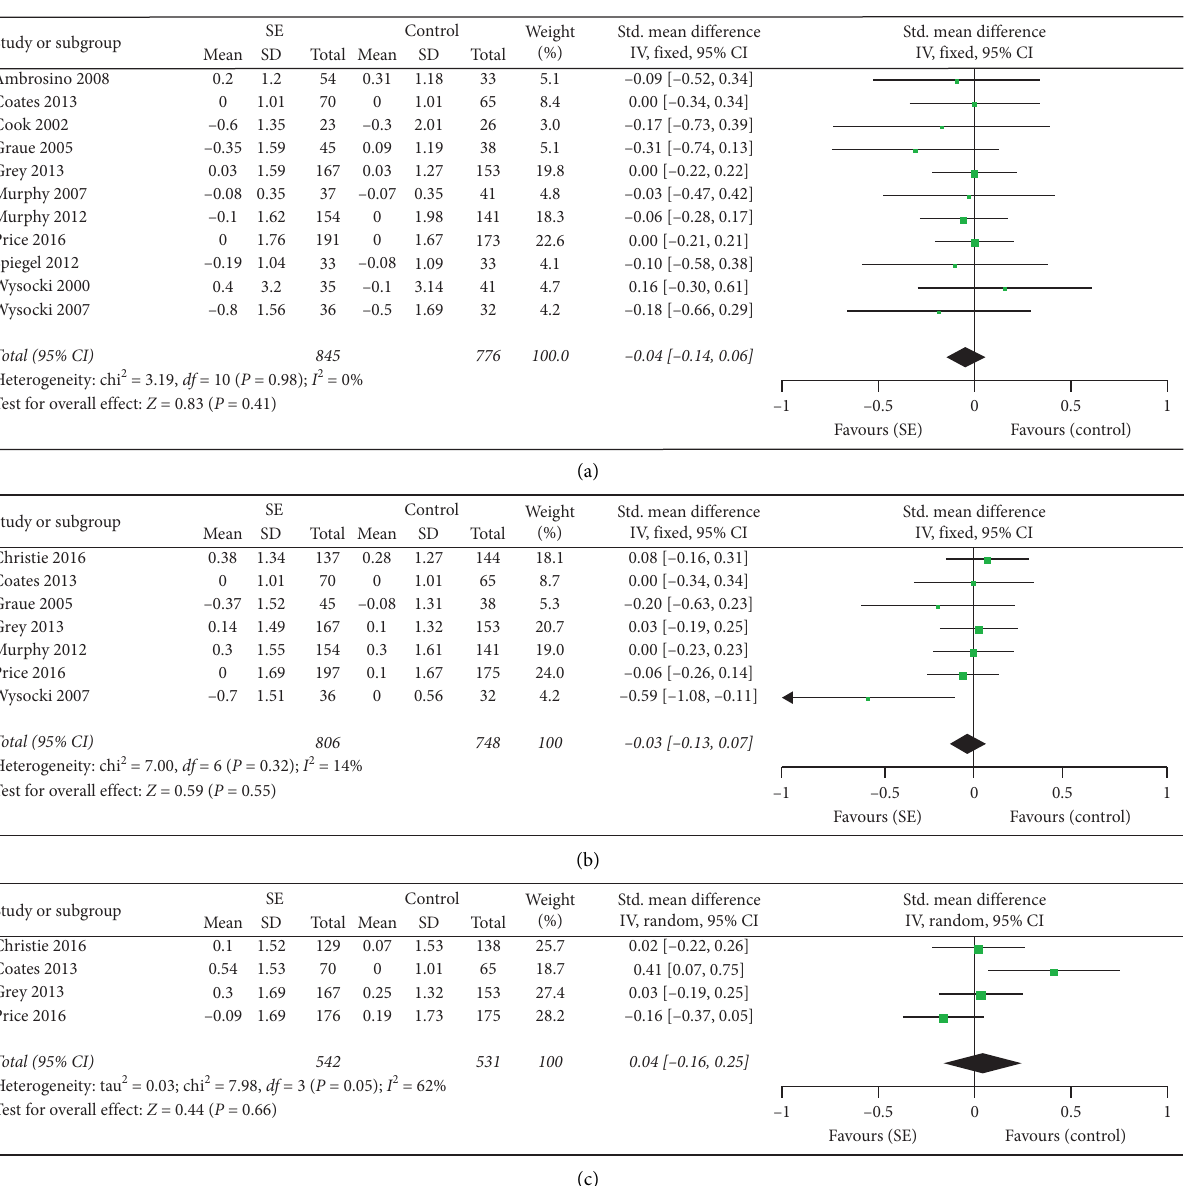
Figure 3: Forest plots showing the effect sizes of SE on HbA1c in adolescent patients with T1DM. (a) Short-term effect, (b) medium-term effect, and (c) long-term effect.